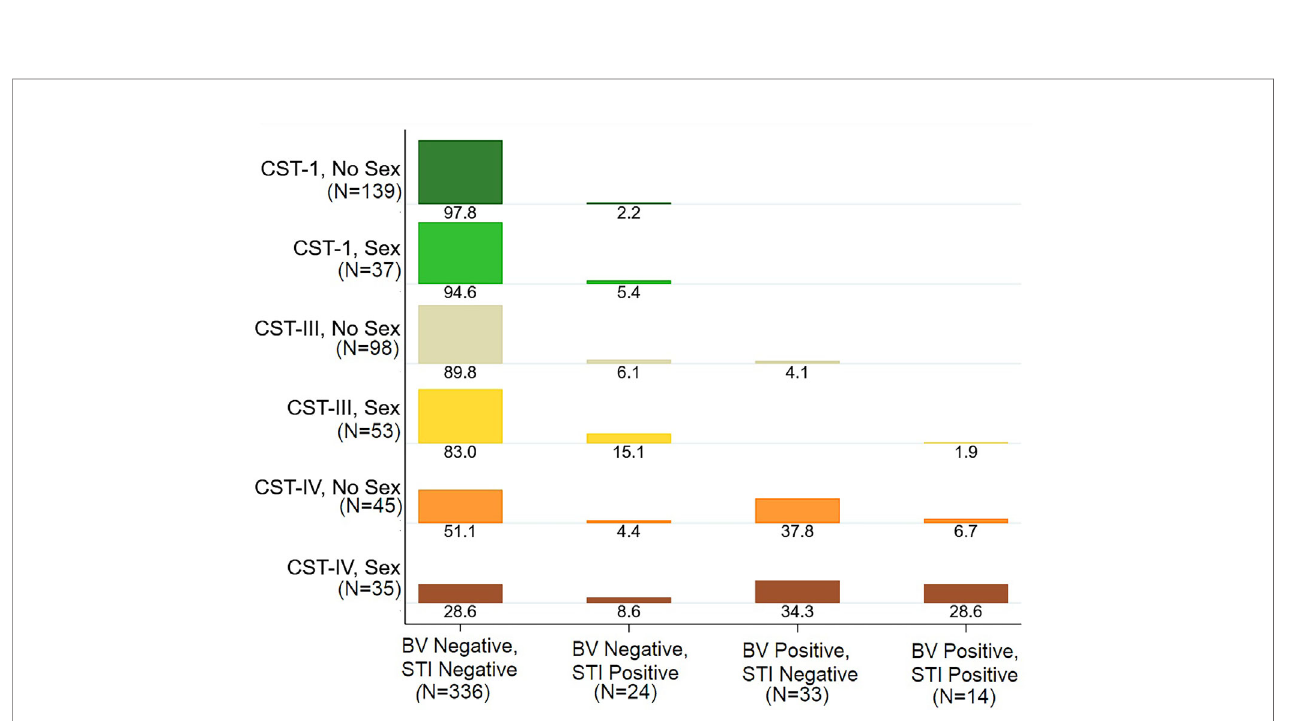
FIGURE 2 | Distribution of Bacterial vaginosis (BV) and Sexually Transmitted Infection (STI) Status by Vaginal Microbiome Community State Type (CST), Strati fi ed by Sexual Activity. Legend: The plot shows the distribution of BV and STI status by vaginal CST, strati fi ed by sexual activity ever. For example, among girls with CST-I who do not report sexual activity, 97.8% were negative for BV and STI and 2.2% were BV Negative and STI positive. Among girls with CST-IV who reported having sexual activity, 28.6% were negative for BV and STI, 8.6% with STI only, 34.3% with BV only, and 28.6% with both BV and